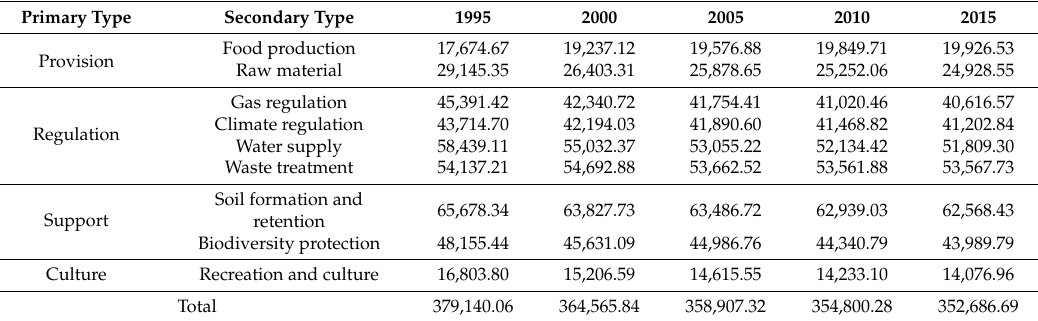
Table 6. Values of ecosystem service functions of Jiangxi province from 1995 to 2015 (unit: 10 6 Yuan).